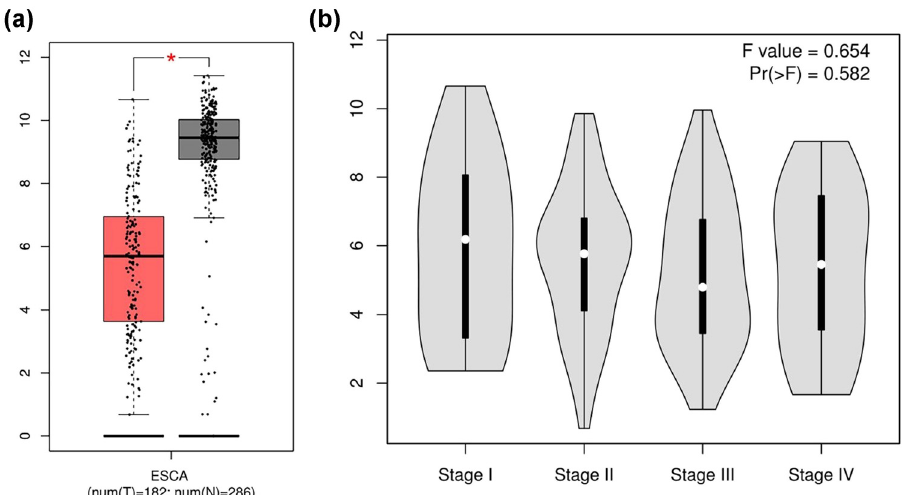
Figure 1: ( a ) Analysis of the expression level of CRABP2mRNA in esophageal cancer tissues and normal esophageal tissues based on the GEPIA database ( red indicates esophageal cancer tissues, gray indicates normal esophageal tissues, and the di ff erence is statistically signi fi cant ) . ( b ) The relationship between CRABP2 and tumor staging.